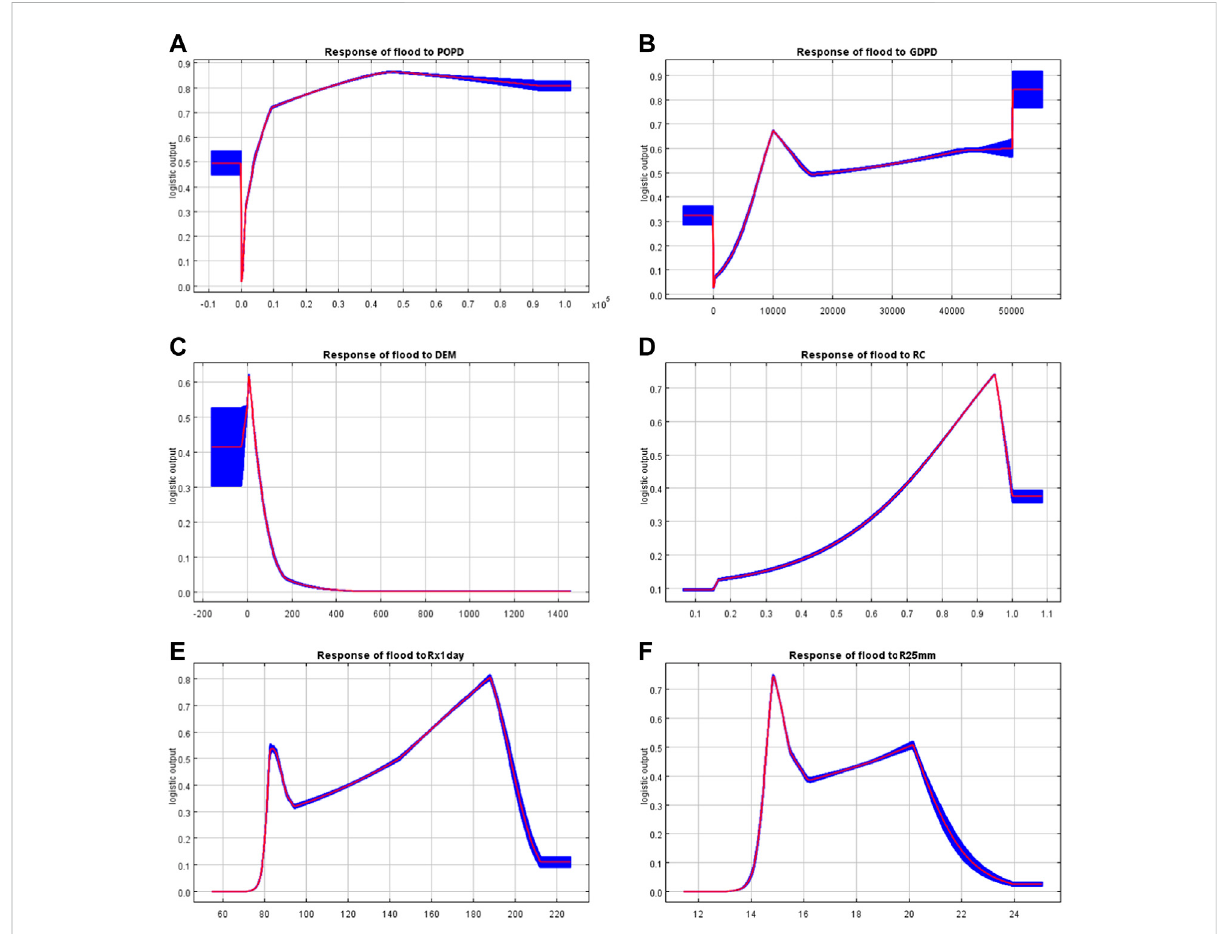
FIGURE 6 Response curves of environmental indices in MaxEnt models. Note: (A) The response curve of POPD, (B) The response curve of GDPD, (C) The response curve of DEM, (D) The response curve of rc, (E) The response curve of Rx1day, (F) The response curve of R25mm.